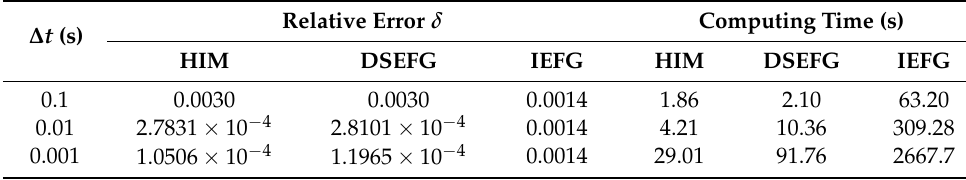
Table 6. Comparison of relative error and computing time when ∆ t is different. ∆ t